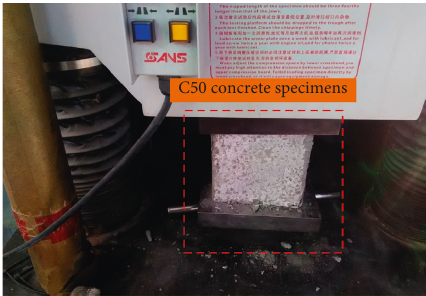
Figure 8: Compressive strength test of model bedrock.